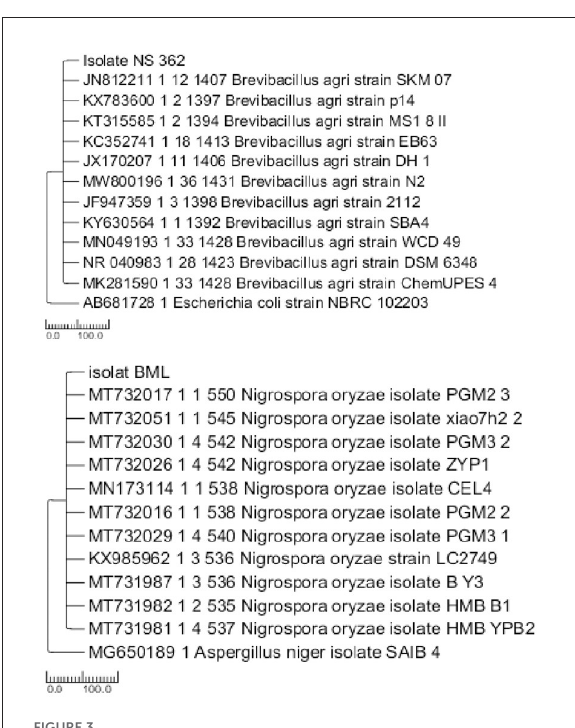
FIGURE3 Phlogeny tree of Brevibacillus agri and Nigrospora oryzae .